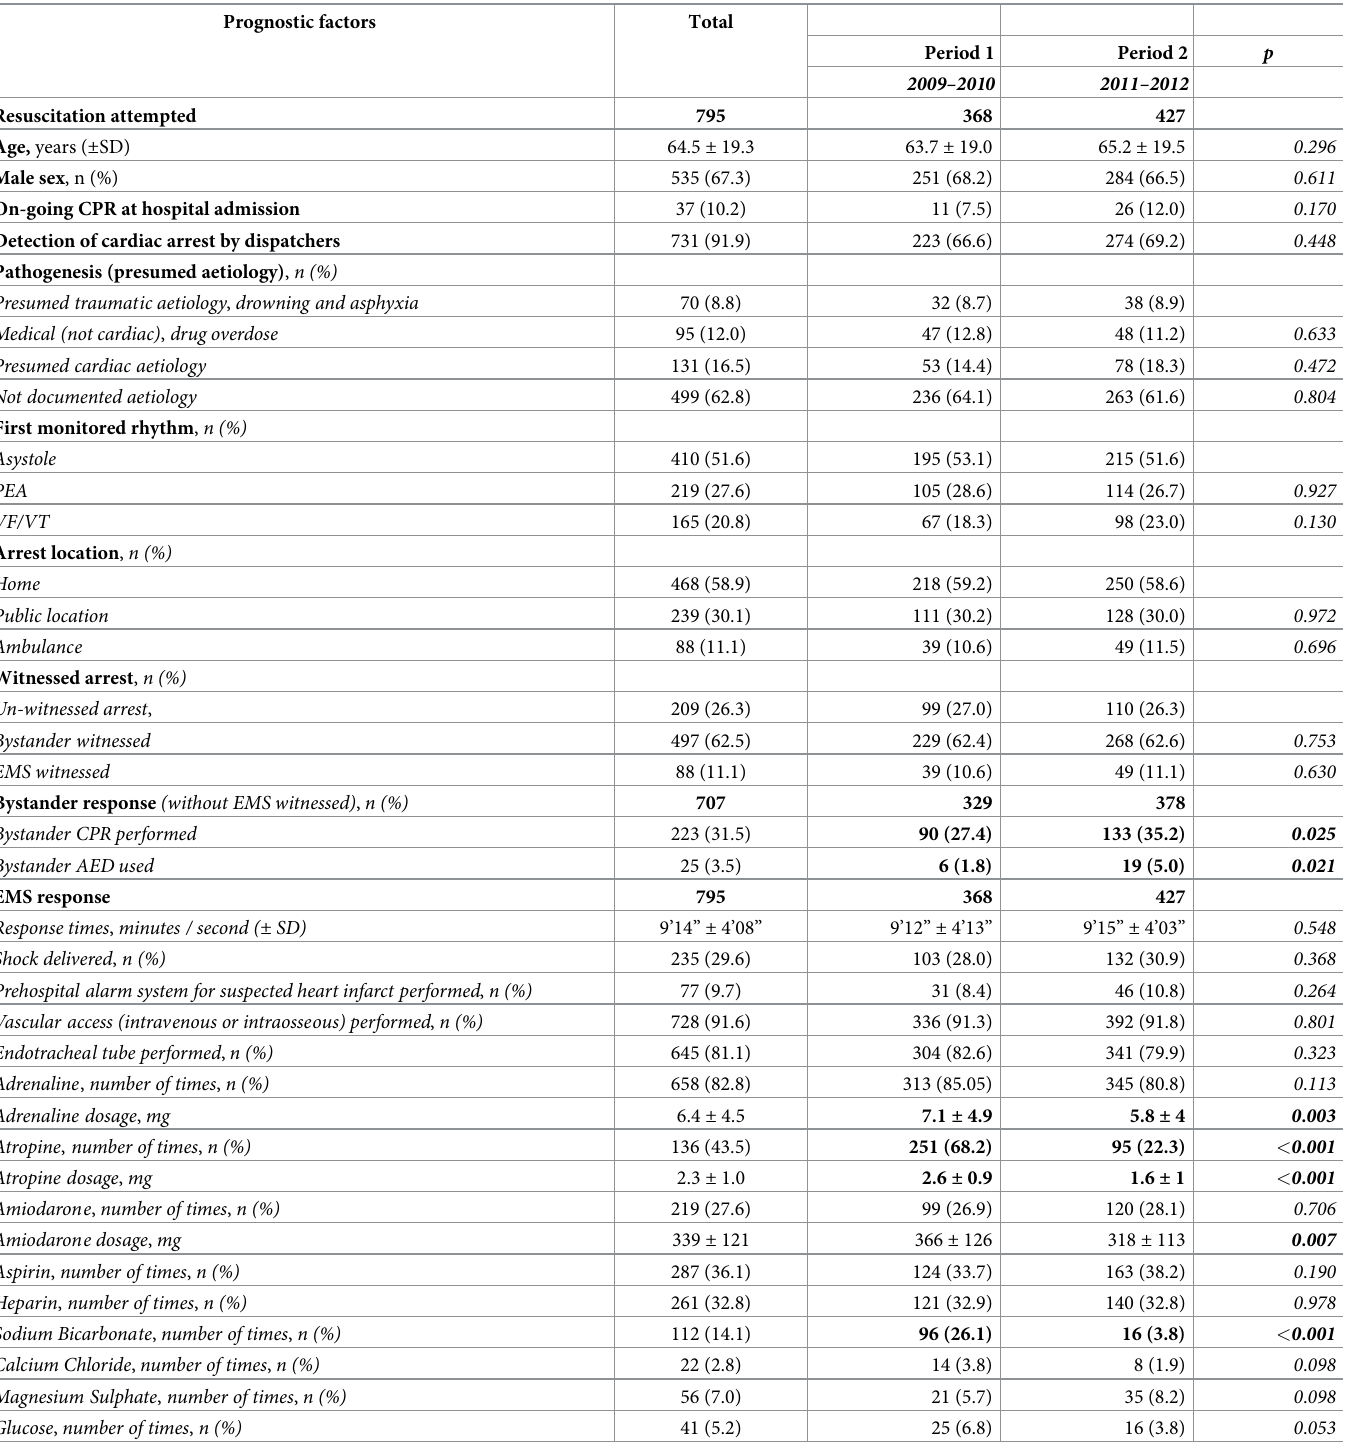
Table 1. Baseline characteristics of patients studied, features and interventions during cardiac arrest events.